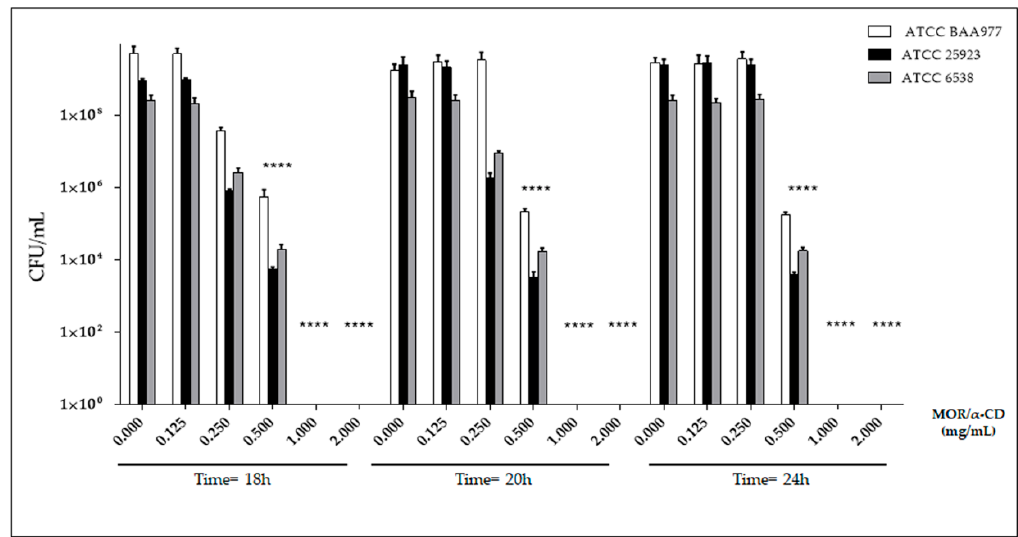
Figure 4. The time kill curve assay. MOR/ α -CD bactericidal activity was assessed against S. aureus ATCC BAA-977, ATCC 25923, and ATCC 6538 strains using the MIC dose (0.5 mg/mL) of MOR/ α -CD and from 2 up to 4-fold the value of MIC for each strain (0.5, 1 and 2 mg/mL). The colony count was made after 18 h, 20 h, and 24 h of treatment. Experiments were assessed in triplicate to obtain the mean and the standard deviation (SD). A statistical analysis (Two way ANOVA) was performed by the GraphPad Prism6 software and the p value < 0.0001 (****) showed a significant difference between the dose of 0.5 mg/mL, 1 mg/mL, and 2 mg/mL of MOR/ α -CD and the untreated bacteria (0 mg/mL) for each strain at different time points.